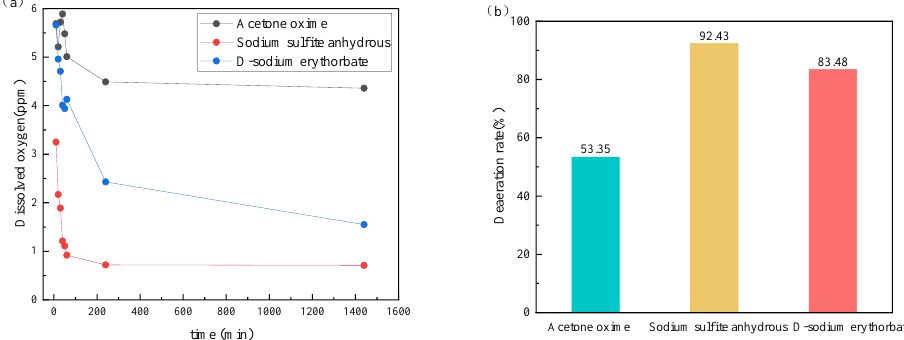
Figure 5. Dissolved oxygen of injected water containing different deoxidizers ( a ) and the deaeration rate of different deoxidizers ( b ).